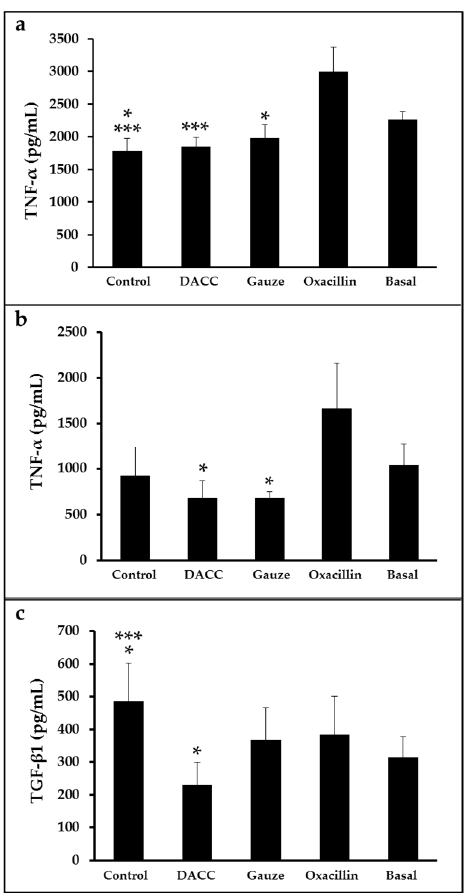
Figure 3. Expression of TNF- α and TGF- β 1 in eukaryotic cell cultures: ( a ) Macrophages treated with the filtered supernatants of S. aureus cultured in Müller-Hinton broth. *, p < 0.05 control vs. basal and gauze vs. oxacillin; ***, p < 0.001 control vs. oxacillin and DACC vs. oxacillin. ( b , c ) co-cultures of fibroblasts and macrophages treated with the filtered supernatants of S. aureus cultured in DMEM. In ( b ), *, p < 0.05 gauze vs. oxacillin and DACC vs. oxacillin. In ( c ), *, p < 0.05 control vs. basal and DACC vs. oxacillin; ***, p < 0.001 control vs. DACC. Values are means ± standard deviations. The basal term refers to cytokine expression in the conditioned medium from non-unstimulated eukaryotic cultures.